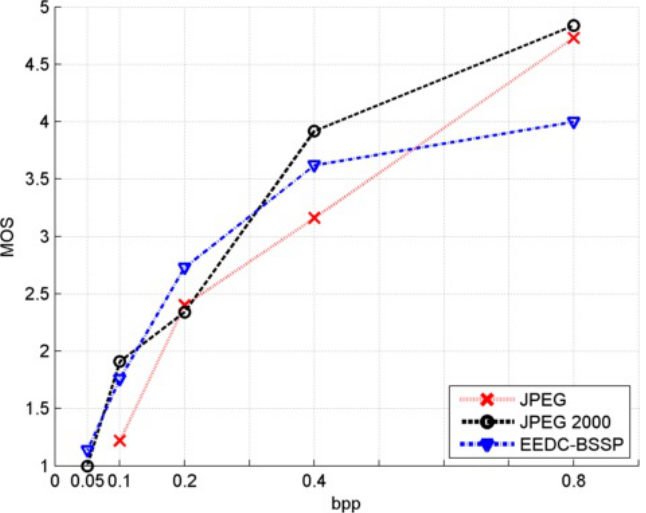
Figure 21. MOS values comparison for EEDC-BSSP with JPEG and JPEG 2000 for image pills